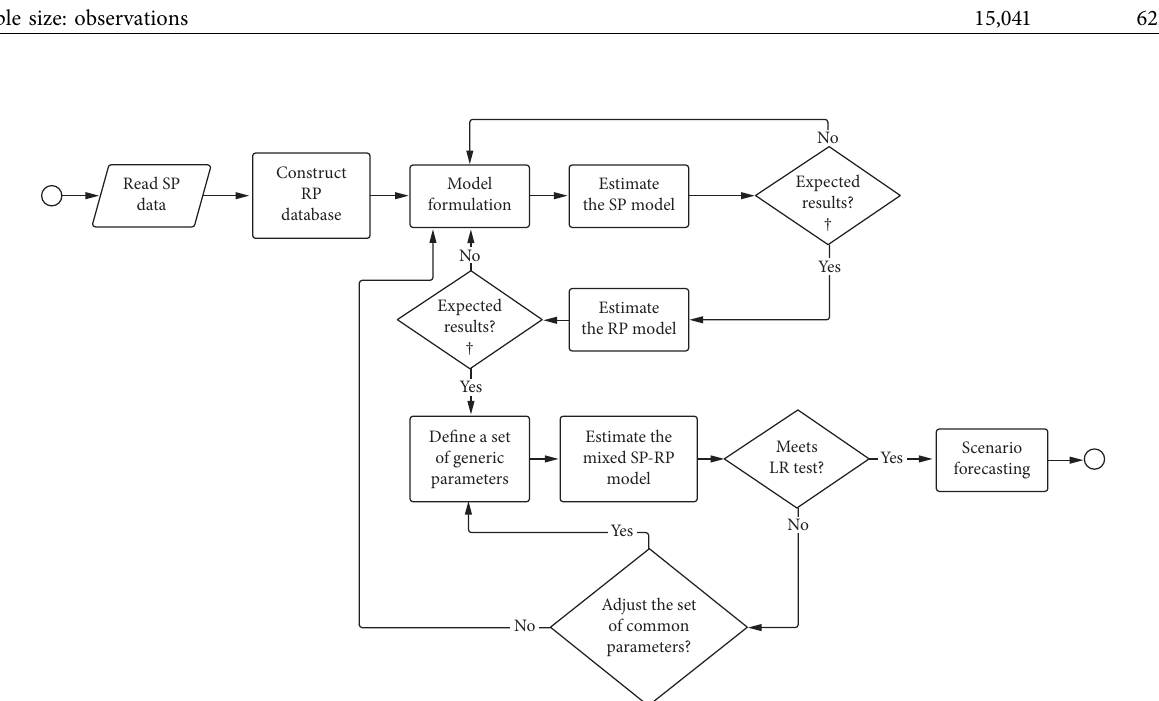
Figure 1: Modelling approach